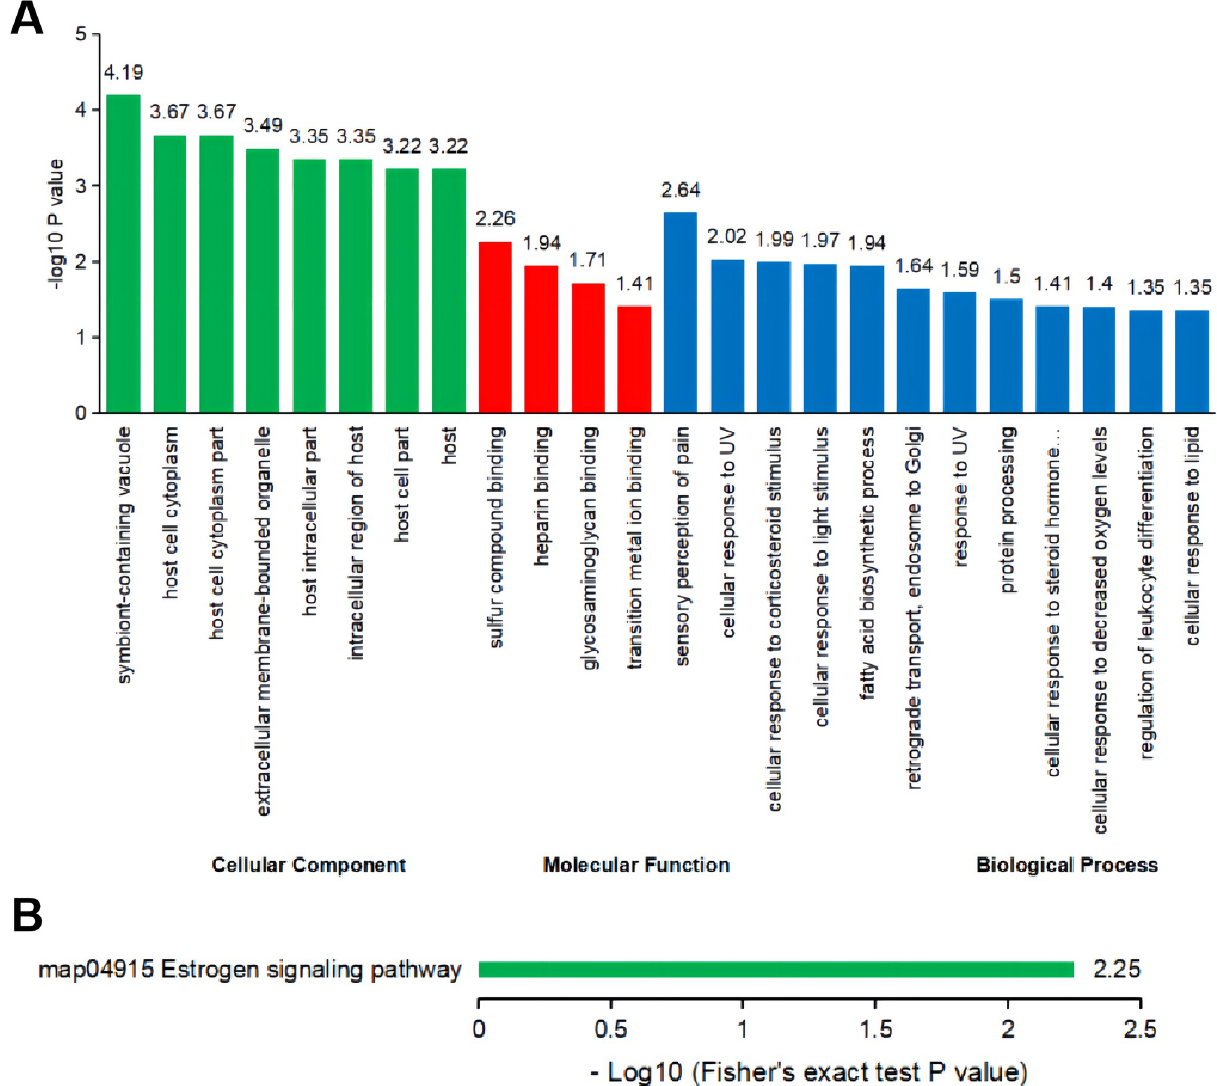
Fig 8. Bioinformatics analysis of placental proteomics. (A) GO enrichment of the differentially expressed proteins was obtained by using Fisher’s exact test. (B) KEGG pathway enrichment of the differentially expressed proteins.